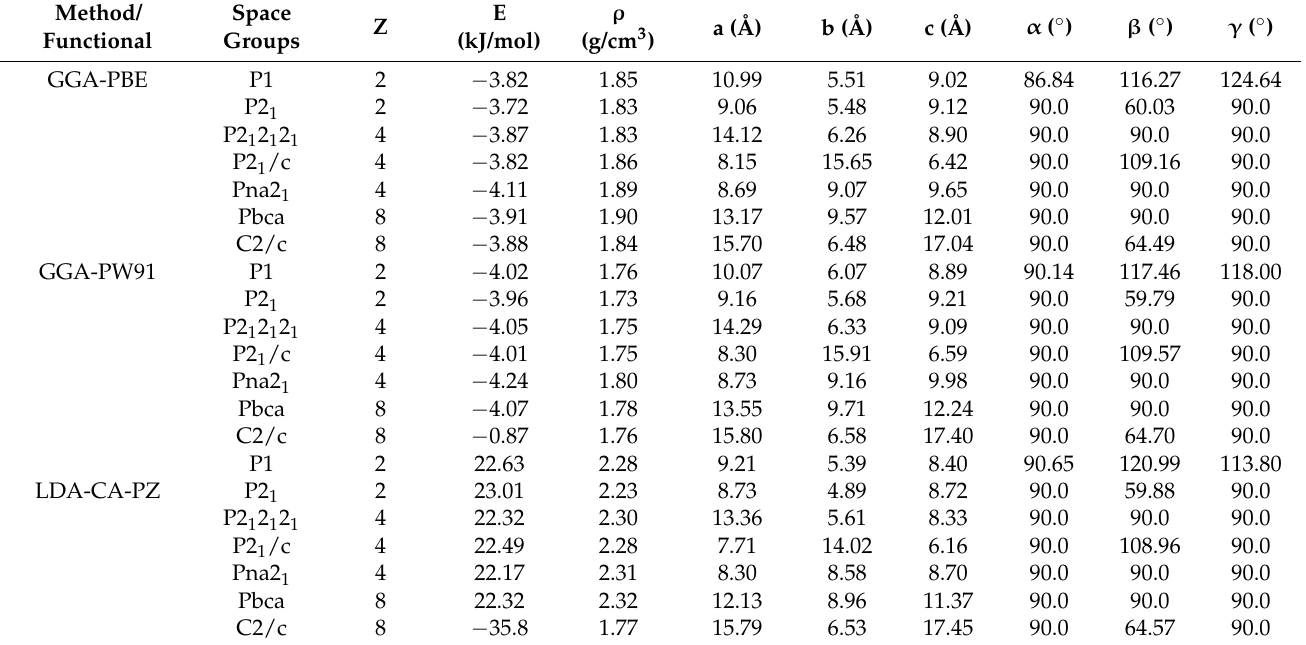
Table 2. Unit cell parameters of the possible molecular packing of TNTA.